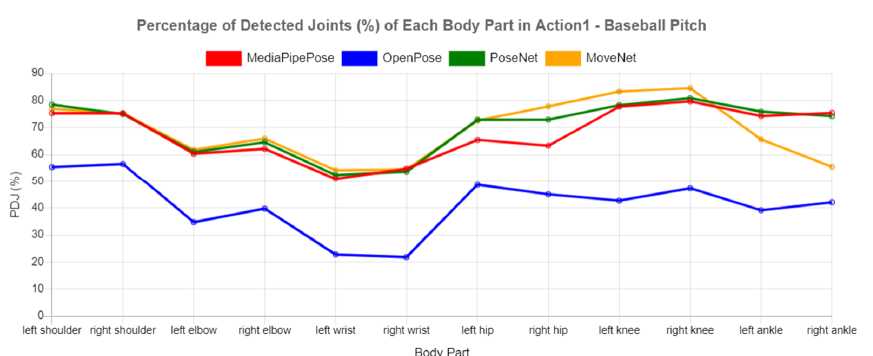
Figure 9. PDJ for each body part in Action 1–baseball pitch.